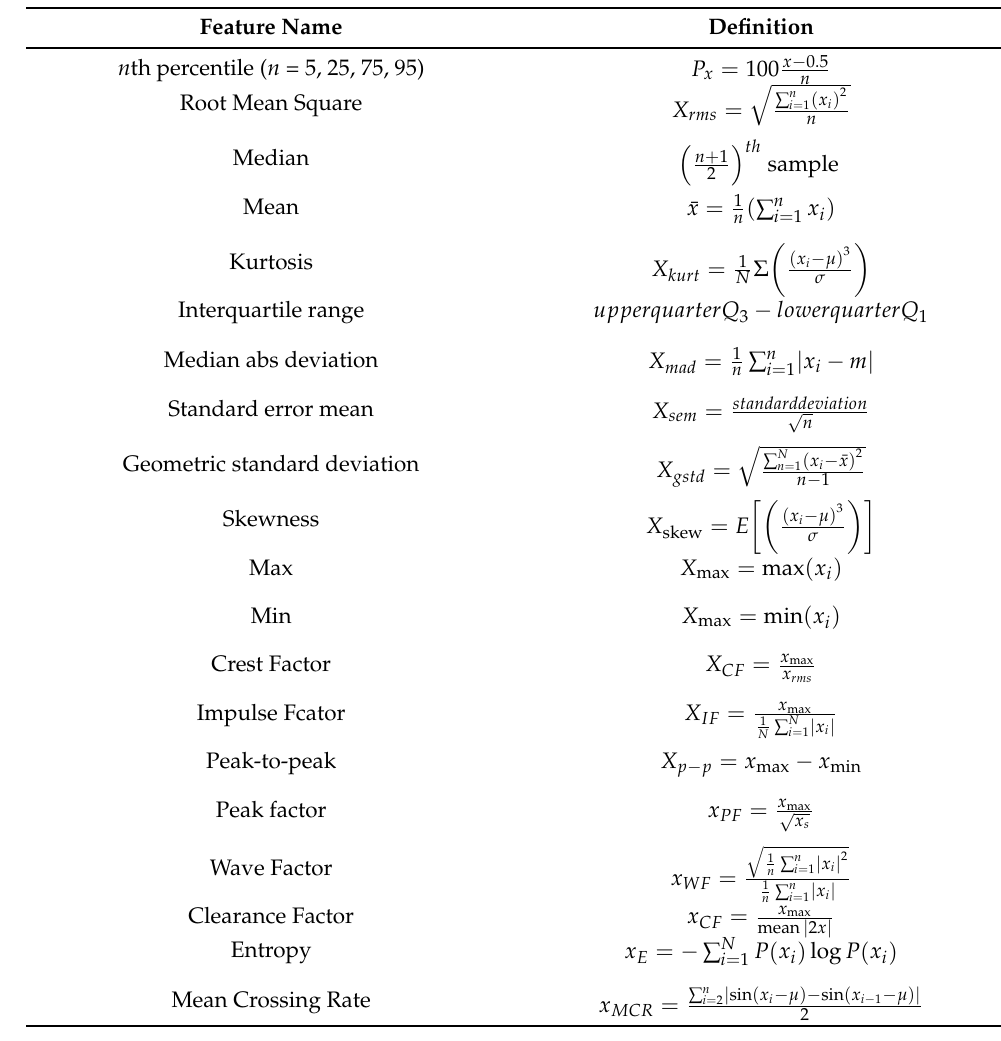
Table 2. Extracted Features and their